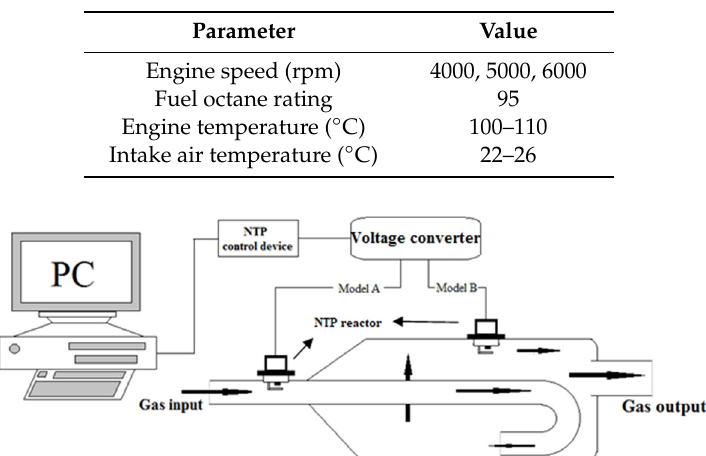
Table 2. The control conditions of engine.